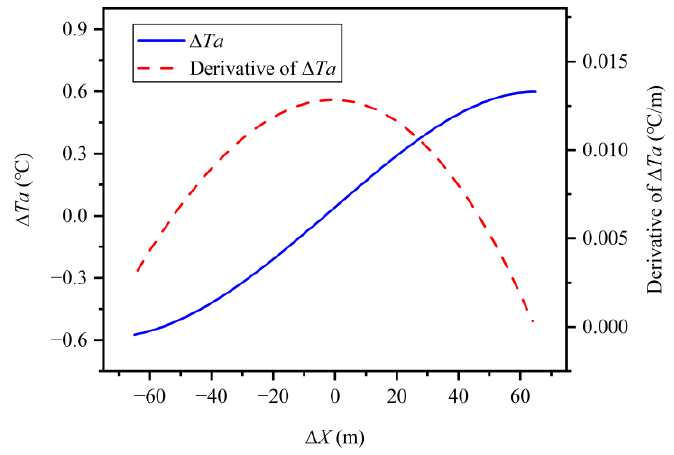
Figure 6. Air Temperature Di ff erence ( ∆ Ta ) varying with Distance ( ∆ X ) at ∆ RH = 0.